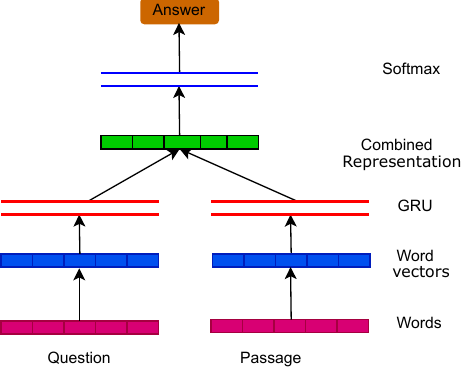
Figure 12. Architecture of gated recurrent unit.